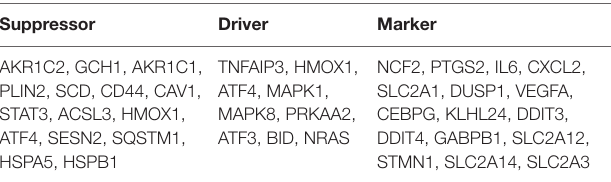
TABLE 3 | The ferroptosis differentially expressed genes were divided into ferroptosis driver, suppressor, and marker. Suppressor Driver Marker AKR1C2, GCH1, AKR1C1, PLIN2, SCD, CD44,